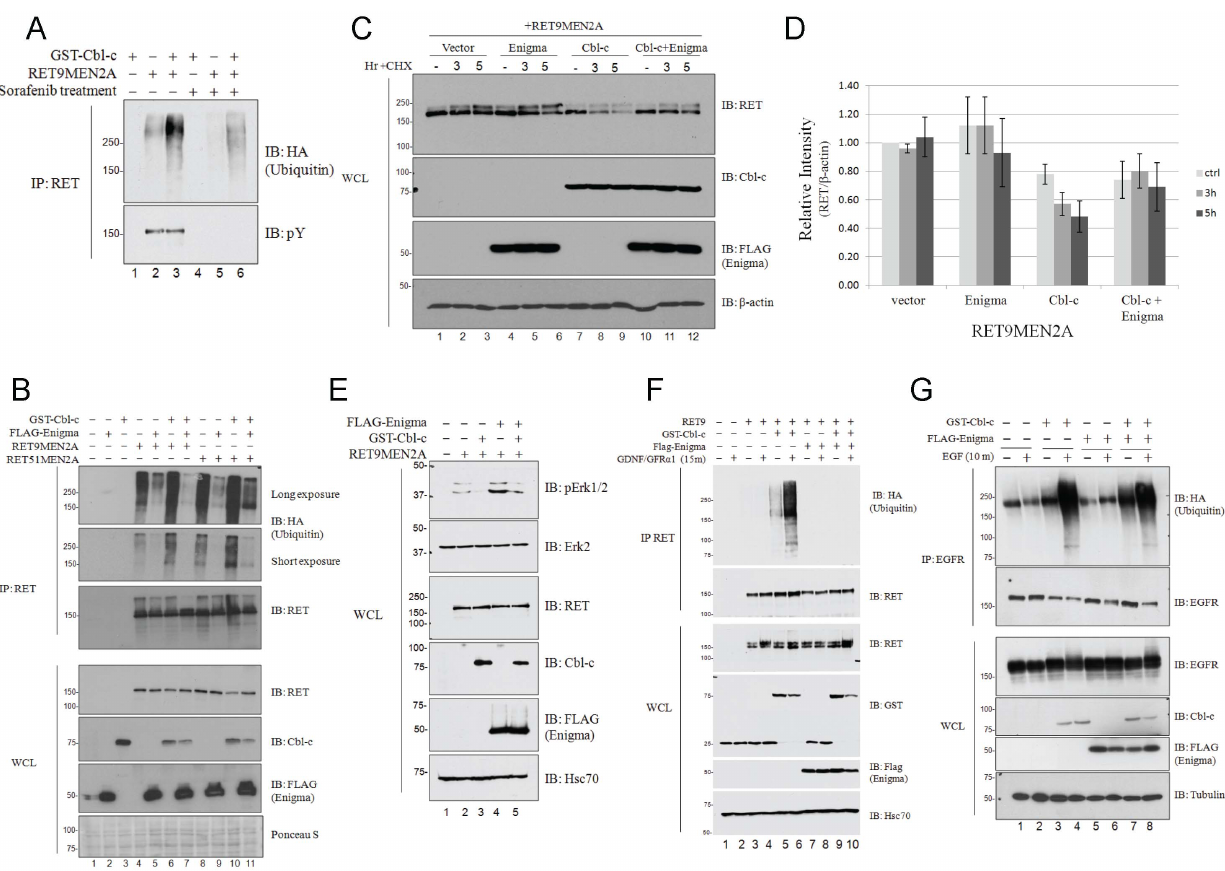
Figure 3. Enigma abrogates RETMEN2A ubiquitination. ( A ) RET immunoprecipitations were performed on 300 m g of each of the whole cell lysates described above and immunoblotted for HA-ubiquitin and phosphotyrosine (pY) as indicated on the right. ( B ) HEK293T cells were transfected with GST-Cbl-c with and without FLAG-Enigma along with either RET9MEN2A or RET51MEN2A. Cells were collected 48h post-transfection, and whole cell lysates were immunoblotted as indicated on the right. RET immunoprecipitations were performed on 300 m g of each of the whole cell lysates and immunoblotted for RET and HA-ubiquitin as indicated on the right. Molecular weight standards are indicated on the left and Ponceau S staining serves as a measure of protein loading. ( C ) HEK293T cells were transfected with RET9MEN2A with GST-Cbl-c and FLAG-Enigma both alone and in combination as indicated above the blots. All transfections were performed in triplicate. At 24h post-transfection, triplicate plates were pooled and replated. At 40h post-transfection, replicate plates were treated with 100ng/mL cycloheximide (CHX) for either 3 or 5h as indicated. Control plates received an equivalent volume of DMSO vehicle control for 5h prior to cell collection. A total of 20 m g of each of the whole cell lysates was immunoblotted as indicated. RET steady state levels were then assessed using b -actin as a loading control. ( D ) Densitometric analysis of RET steady state levels in the presence of GST-Cbl-c and Enigma, either alone or in combination. Levels were all compared to Vector transfected cells in the absence of cycloheximide. Error bars denote mean 6 SE (n =3). ( E ) HEK293T cells were transfected with RET9MEN2A with GST-Cbl-c and FLAG- Enigma both alone and in combination as indicated above each blot. At 24h post-transfection, all cells were starved of FBS for 24h prior to cell harvesting. A total of 20 m gs of each of the whole cell lysates were immunoblotted as indicated to the right of each panel. Phospho-MAPK steady state levels were assessed using MAPK and Hsc70 as loading controls. Molecular weight standards are indicated on the left of each panel. ( F ) HEK293T cells were transfected with wild-type RET and the RET co-receptor, GFR a 1 along with GST-Cbl-c and Enigma both alone and in combination. Vector controls included empty GST vector and all transfections were performed in duplicate and included HA-tagged ubiquitin. At 24h post-transfection, duplicate plates were pooled and re-plated to allow reattachment overnight. At 40h post-transfection, plates were rinsed and starved in media lacking FBS for 24h, then stimulated as described previously [43], using 30ng/mL GDNF and 100ng/mL exogenous GFR a 1 ( + ) or water control (-) for 15m as indicated prior to collection and lysis. Whole cell lysates were immunoblotted as indicated. To assess RET ubiquitination, RET immunoprecipitations were performed on 300ugs of whole cell lysate and immunoblotted for HA-ubiquitin as indicated on the right. ( G ) HEK293T cells were transfected with EGFR along with GST-Cbl-c and Enigma both alone and in combination. All transfections were performed in duplicate. At 24h post-transfection, duplicate plates were pooled and replated to allow reattachment overnight. At 40h post-transfection, plates were rinsed and starved in media lacking FBS for 8h, then stimulated with 100ng/mL EGF ( + ) or water control (-) for 10m as indicated prior to collection and lysis. Whole cell lysates were immunoblotted as indicated. To assess EGFR ubiquitination, EGFR immunoprecipitations were performed on 300 m g of whole cell lysate and immunoblotted for EGFR and HA-ubiquitin as indicated on the right. Molecular weight standards are shown to the left of each panel and tubulin serves as loading control.